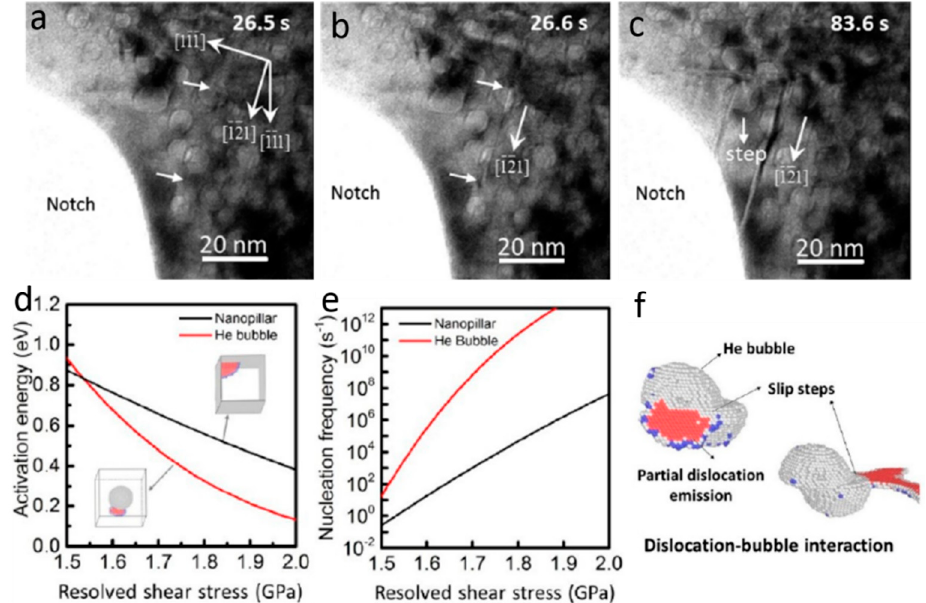
Figure 22. ( a – c ) A partial dislocation nucleates from He bubble and cuts through adjacent He bubbles, leaving a stacking fault and slip steps on bubbles. ( d , e ) A simulation demonstrates that He bubbles are preferable dislocation nucleation sites. For resolved shear stress higher than 1.5 GPa, the activation energy for dislocation nucleation from He bubbles is lower than that from pillar surface/corner, leading to higher dislocation nucleation frequency from He bubbles. ( f ) Slip steps on He bubbles also serve as dislocation nucleation sites. Reprinted with permission from [122]; Copyright 2016 American Chemical Society.